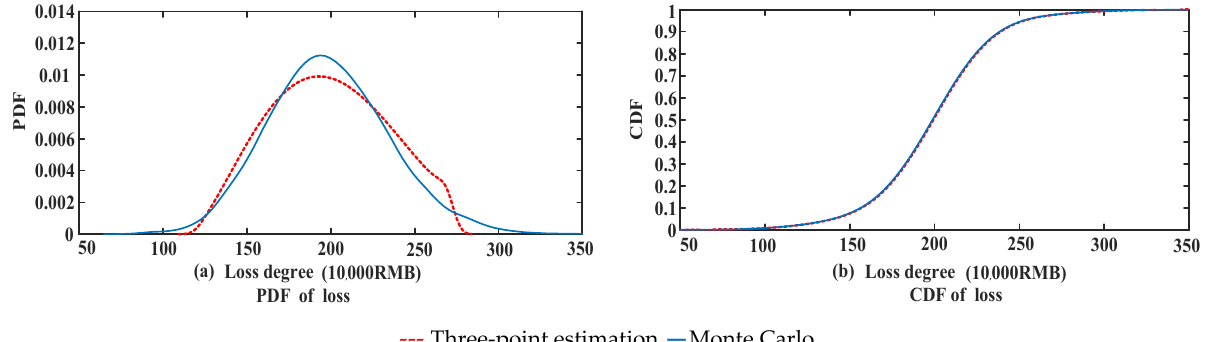
Figure 4. PDF and CDF of loss degree caused by Transformer 1 fault.